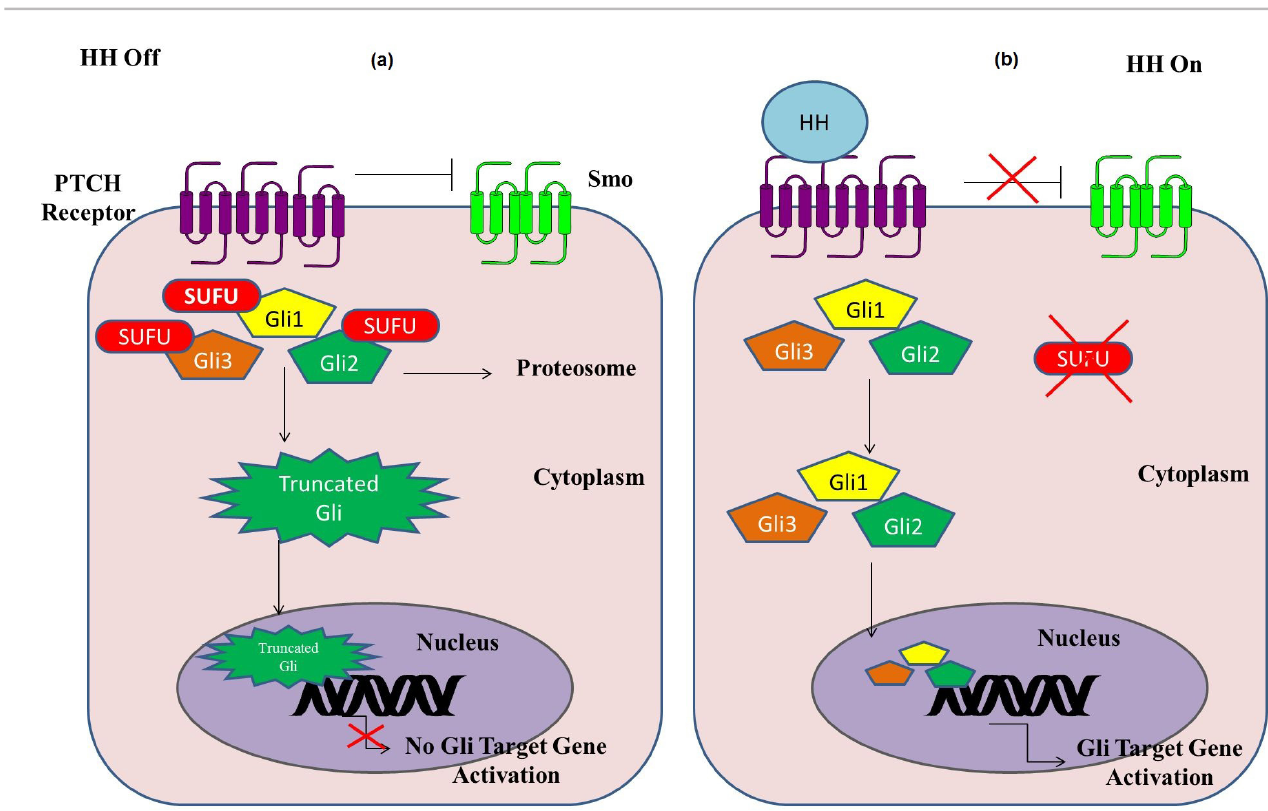
FIGURE 1 -S chematic representation of the Hedgehog (HH) Signaling Pathway (a) In the absence of HH ligand, suppressor of Fused (SUFU) binds to GLI transcription factors in the cytoplasm preventing its translocation to the nucleus. (b) In the presence of HH ligand, the ligand binds to Patched (PTCH) receptors leading to activation of Smoothened (SMO) transmembrane proteins consequently deactivating SUFU and enabling the translocation of GLI transcription factors to the nucleus which ultimately activates downstream target